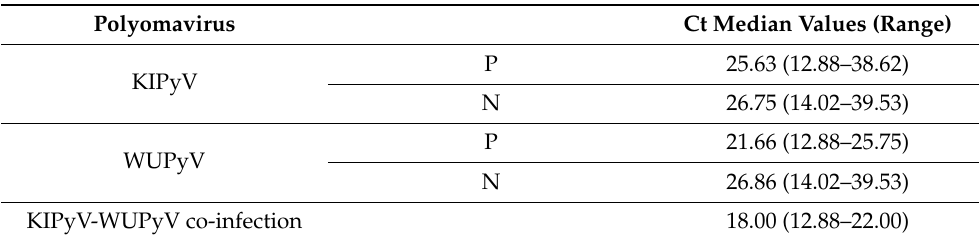
Table 3. Analysis of SARS-CoV-2 Ct values according to the KIPyV and WUPyV detection.